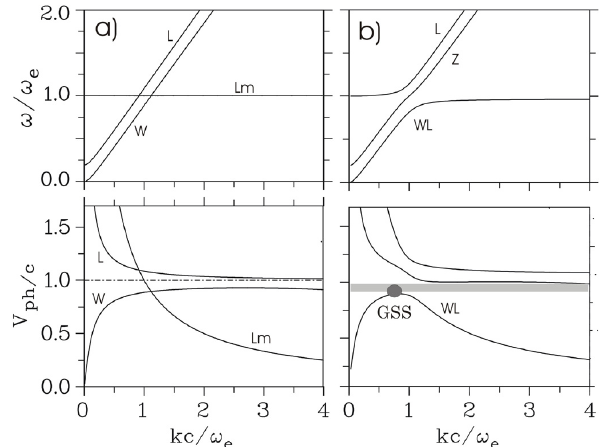
Fig. 2. Frequency ω / ω e and phase velocity V ph /c versus wave num- ber kc/ω e for two propagation angles; (a) θ = 0 ◦ , (b) θ = 15 ◦ , G = 5. Mode splitting which occurs at oblique propagation is clearly seen. Coupling between the whistler mode (W) and the Langmuir mode (Lm) leads to the whistler-Langmuir mode (WL). The original whistler mode at large wave numbers is named the Z- mode. The GSS point in Fig. 2b indicates maximum phase velocity. The gap above this point, drawn as a shaded grey strip, marks the region in which WL oscillitons are